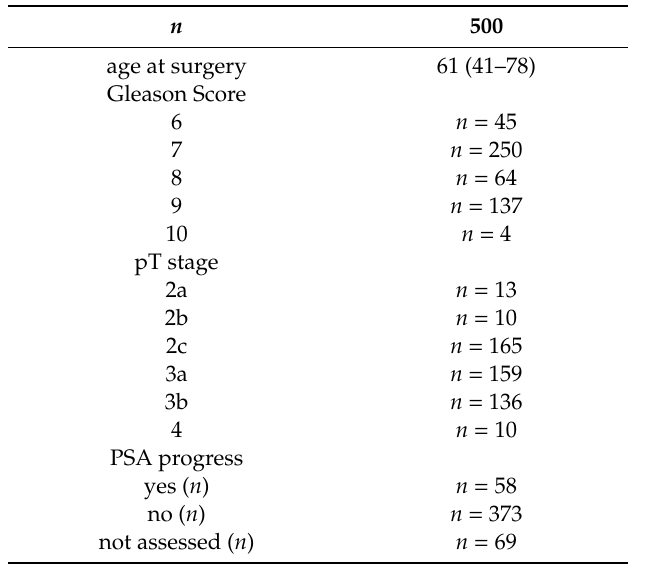
Table 2. Characteristics of the prostate cancer (PCa) cohort within the TCGA (The Cancer Genome Atlas)